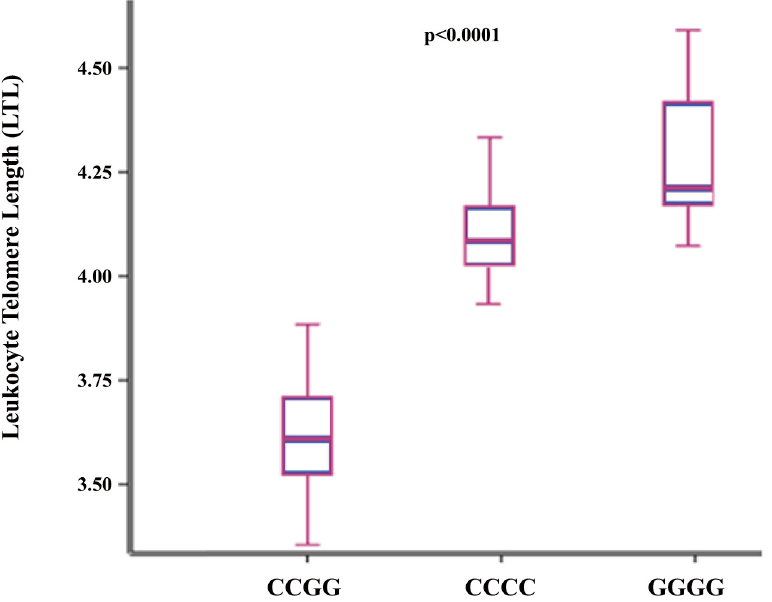
Fig 1. Box plots show the distribution of Leukocyte Telomere Length [LTL]. The horizontal line within the box corresponds to the median value. Vertical bars represent the values between 2.5 th to 97.5 th percentiles excluding